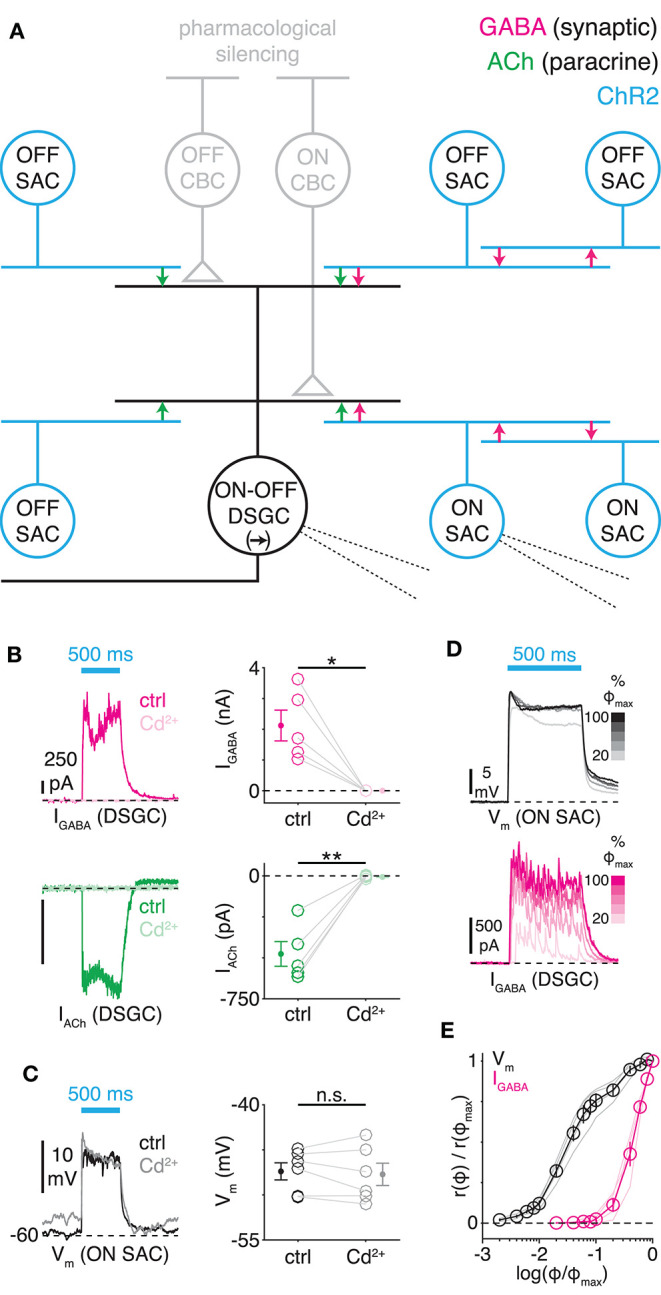
Optogenetic stimulation of starburst amacrine cells evokes postsynaptic currents in ON-OFF direction-selective ganglion cells. (A) An ON-OFF DSGC receives excitatory cholinergic and inhibitory GABAergic input from ON and OFF SACs. Neighboring SACs also provide GABAergic inhibition to each other. SACs express channelrhodopsin-2 (ChR2, blue), which is activated after blocking conventional glutamatergic transmission from photoreceptors and cone bipolar cells (CBCs; see Materials and Methods). (B) ChR2-evoked postsynaptic currents (PSCs) depend on voltage-gated calcium channels. Left, ChR2-evoked GABAergic IPSCs (IGABA) and cholinergic EPSCs (IACh) recorded in separate ON-OFF DSGCs before (ctrl) and during bath application of cadmium (Cd2+, 200 μM). Stimulus intensity, 4.8 × 1017 quanta (Q) cm−2 s−1. Right, peak amplitude of ChR2-evoked PSCs before and during Cd2+ application (n = 5 cells). IGABA–ctrl vs. Cd2+: *p = 0.014, t = 4.2; IACh–ctrl vs. Cd2+: **p = 0.003, t = 6.6 (paired t-tests). Error bars here and below indicate ± SEM across cells. (C) ChR2-mediated modulation of SAC Vm. Left, ChR2-modulated Vm of ON SAC before and during bath application of Cd2+. Right, mean ChR2-evoked depolarization before and during Cd2+ application (n = 6 cells). (D) Dynamic range of ChR2-mediated responses. Within a range of stimulus intensity [20-100% Φmax (4.8 × 1017 Q cm−2 s−1)], ON SAC Vm remains saturated while IPSCs increase. (E) Normalized input-output relations for ChR2-modulated ON SAC Vm (n = 4 cells) and ON-OFF DSGC IPSCs (n = 4 cells); light traces indicate individual cells. r(Φ) is the response to a stimulus of intensity Φ.